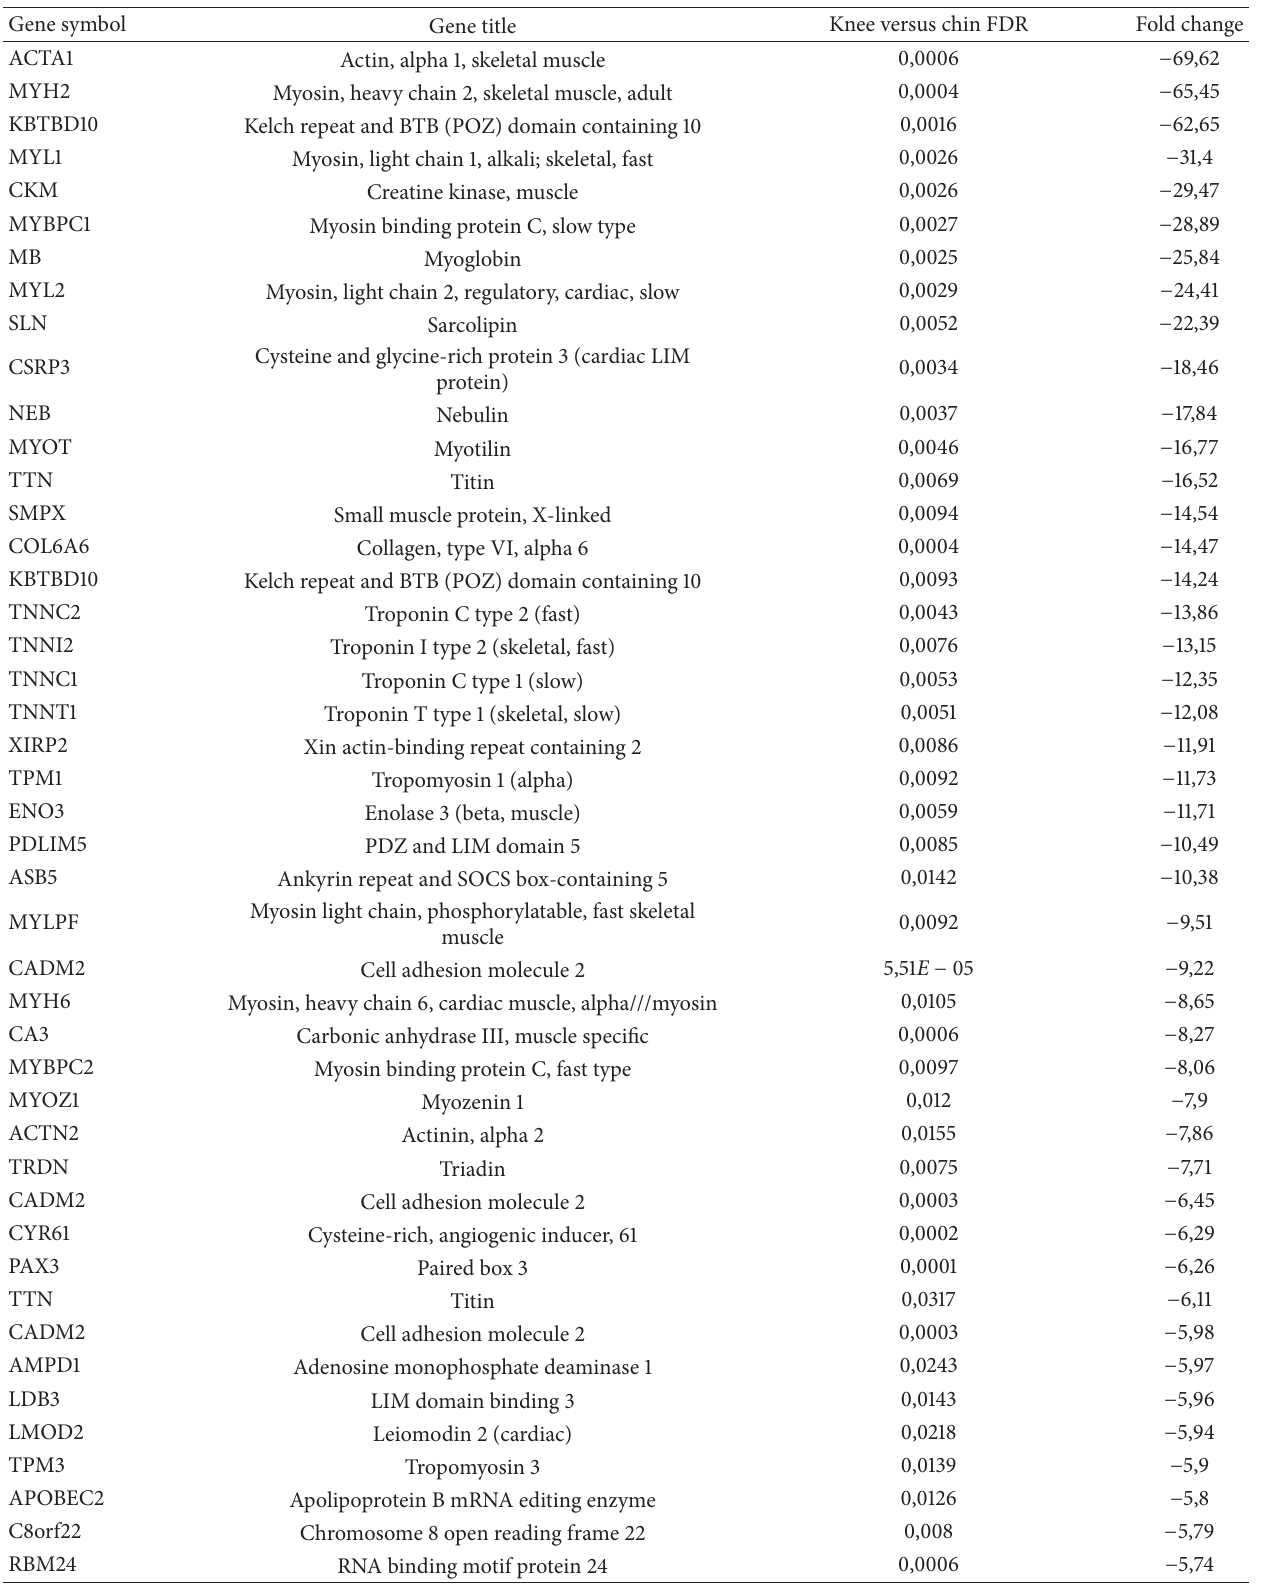
Table 1: TOP50 of the down- and upregulated genes between knee and chin adipose tissue depots from the large scale transcriptomic